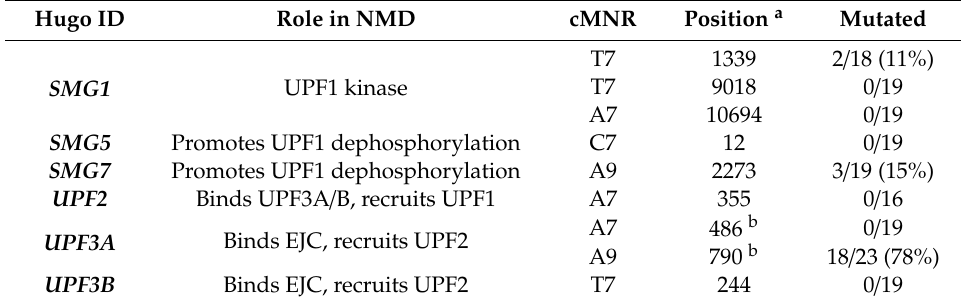
Table 1. Frameshift mutation frequencies in NMD-related genes.